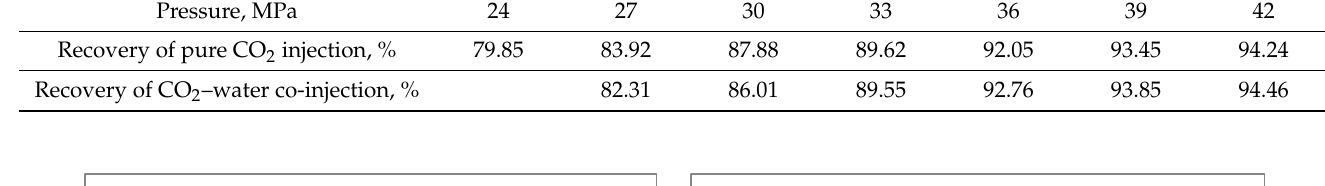
Table 8. The recovery of crude oil at different injection pressures. Pressure, MPa